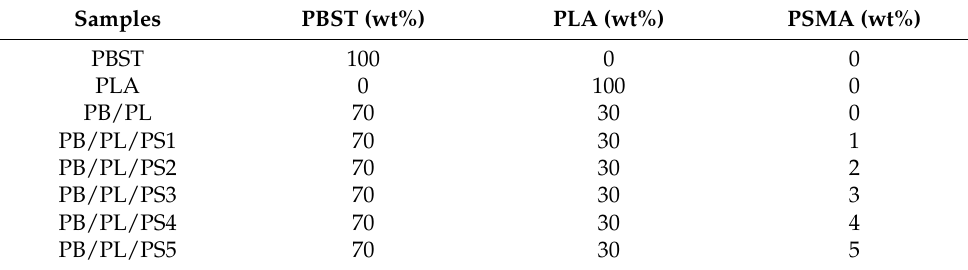
Table 1. Formulations investigated in the present